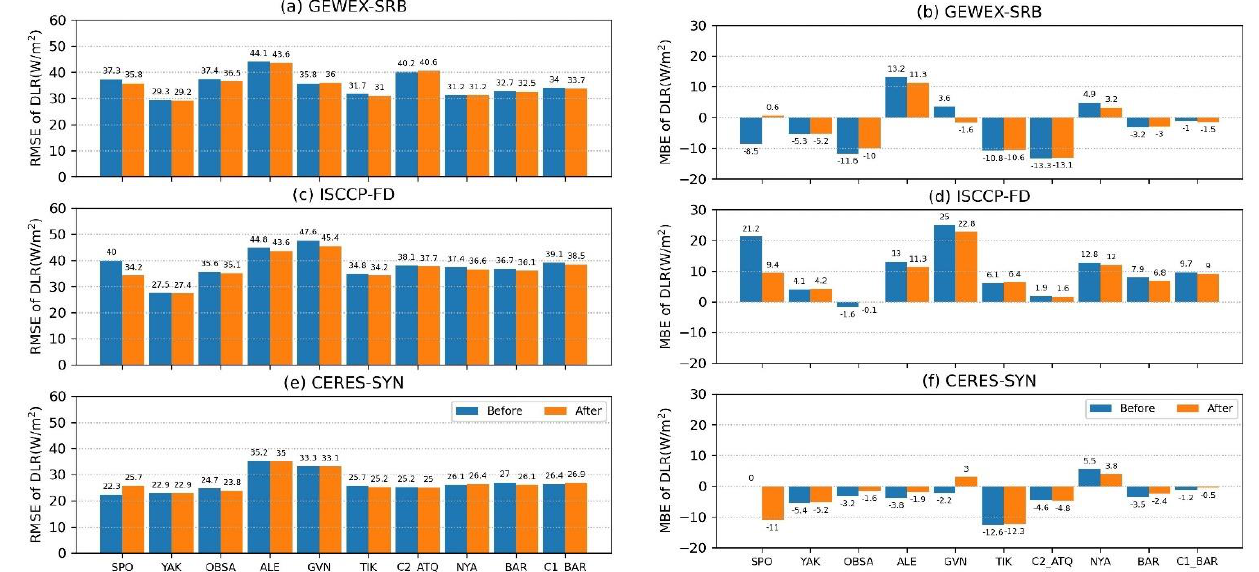
Figure 9. RMSE ( left column ) and MBE ( right column ) of DLR before and after elevation correction at each site.